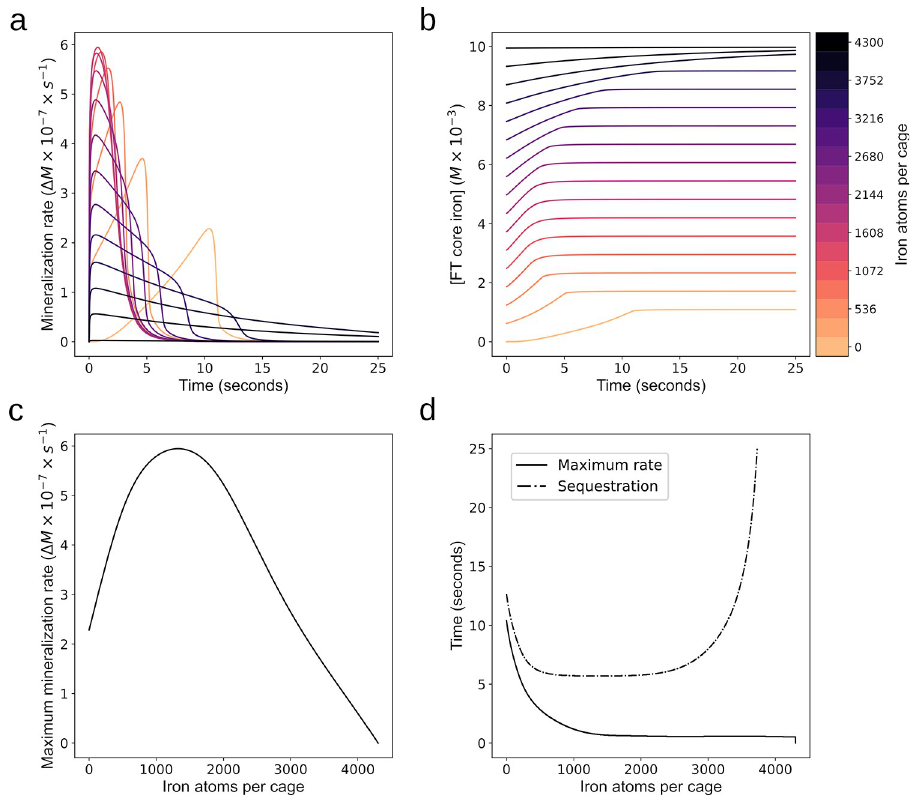
Fig 3. Iron atom per core effect on FT dynamics. a. Mineralization rate over time as a function of iron APC. a series of simulations were run for which the initial ferritin concentration was 2.32 × 10 -6 M and iron added was 1.09 × 10 − 3 M, corresponding to 470 iron atoms per cage, while the initial iron content (APC) varied from 0 to 4300 (as indicated by the colorbar on the right). b. Core accumulation over time as a function of initial APC . From the same simulations that generated the plots in A, here the total core mineralization is plotted over time with the same variation in iron per cage of 0 to 4300 atoms. c. Maximum mineralization rate. Plotted is the maximum value for the mineralization rate as a function of iron atoms per cage. This is the maximum value from the curve in a over the entire time course. d. Time to sequestration and time to maximum mineralization rate . Plotted is the time taken to reach the maximum value for the mineralization rate shown in c. Also plotted is the time taken for 99% of the LIP in solution to be sequestered dependent on initial iron atoms per cage. For values over 3729 atoms per cage it took longer than the 25 second time